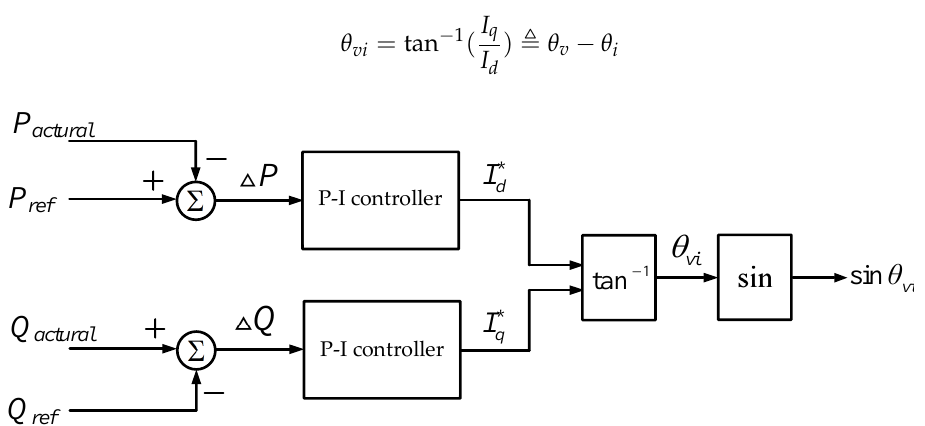
Figure 8. The control scheme for the phase angle of the smart inverter.